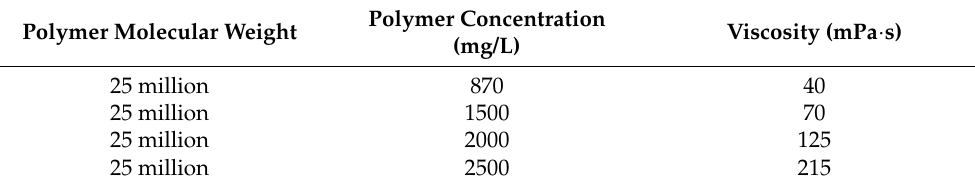
Table 1. Viscosity of polymer solutions with different molecular weights and concentrations. Polymer Molecular